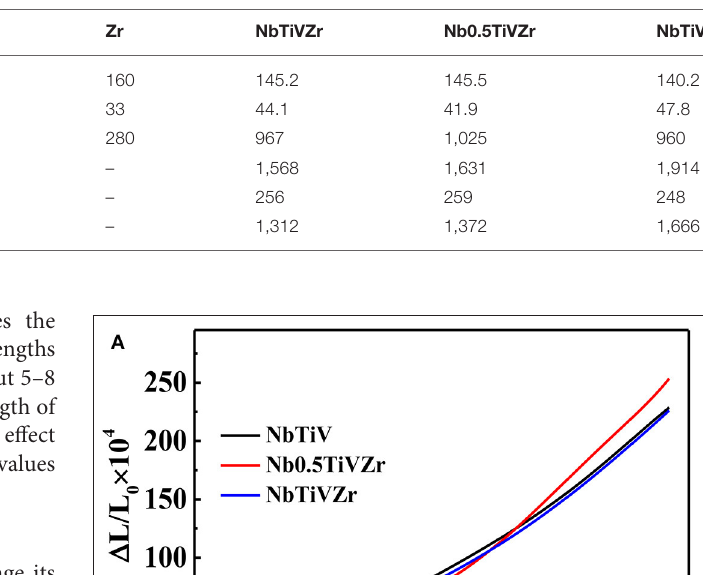
TABLE 1 | Atomic radius ( r ), shear modulus ( G ) and yield strength ( σ 0.2 ) of pure metals (Nb, Ti, V, Zr) as well as the calculated values ( σ mix 0.2 ) using the rule of mixing, solution-strengthening values ( 1σ ), and calculated yield strengths ( σ cal